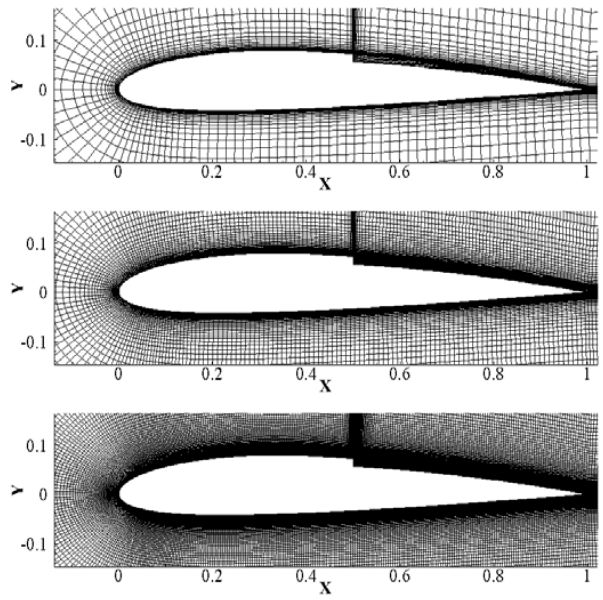
Figure 3. Three consecutively refined meshes used to estimate the spatial convergence.